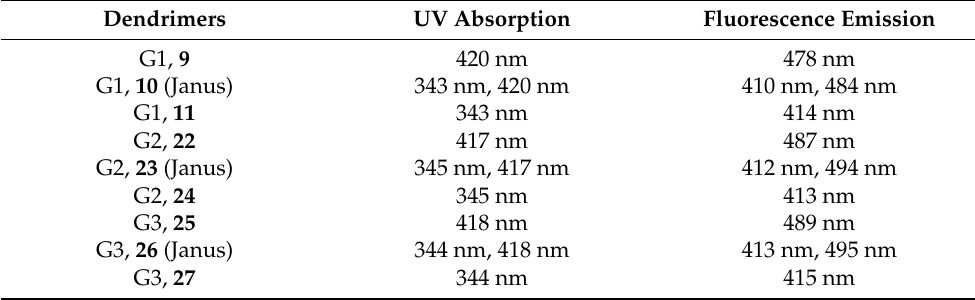
Table 1. Absorption and emission wavelengths of G1–G3